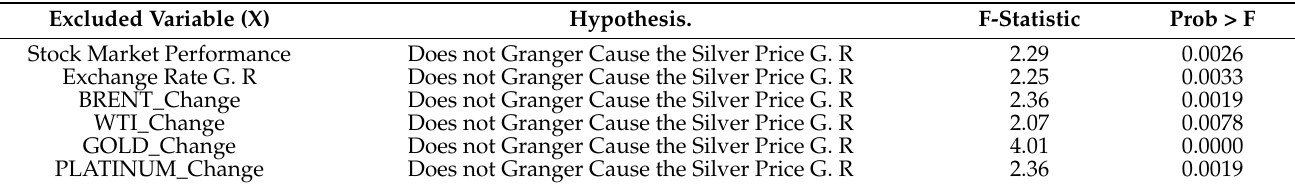
Table A14. Granger Causality test related to the Silver Price G. R (Regression with Driscoll–Kraay Approach). Excluded Variable (X)